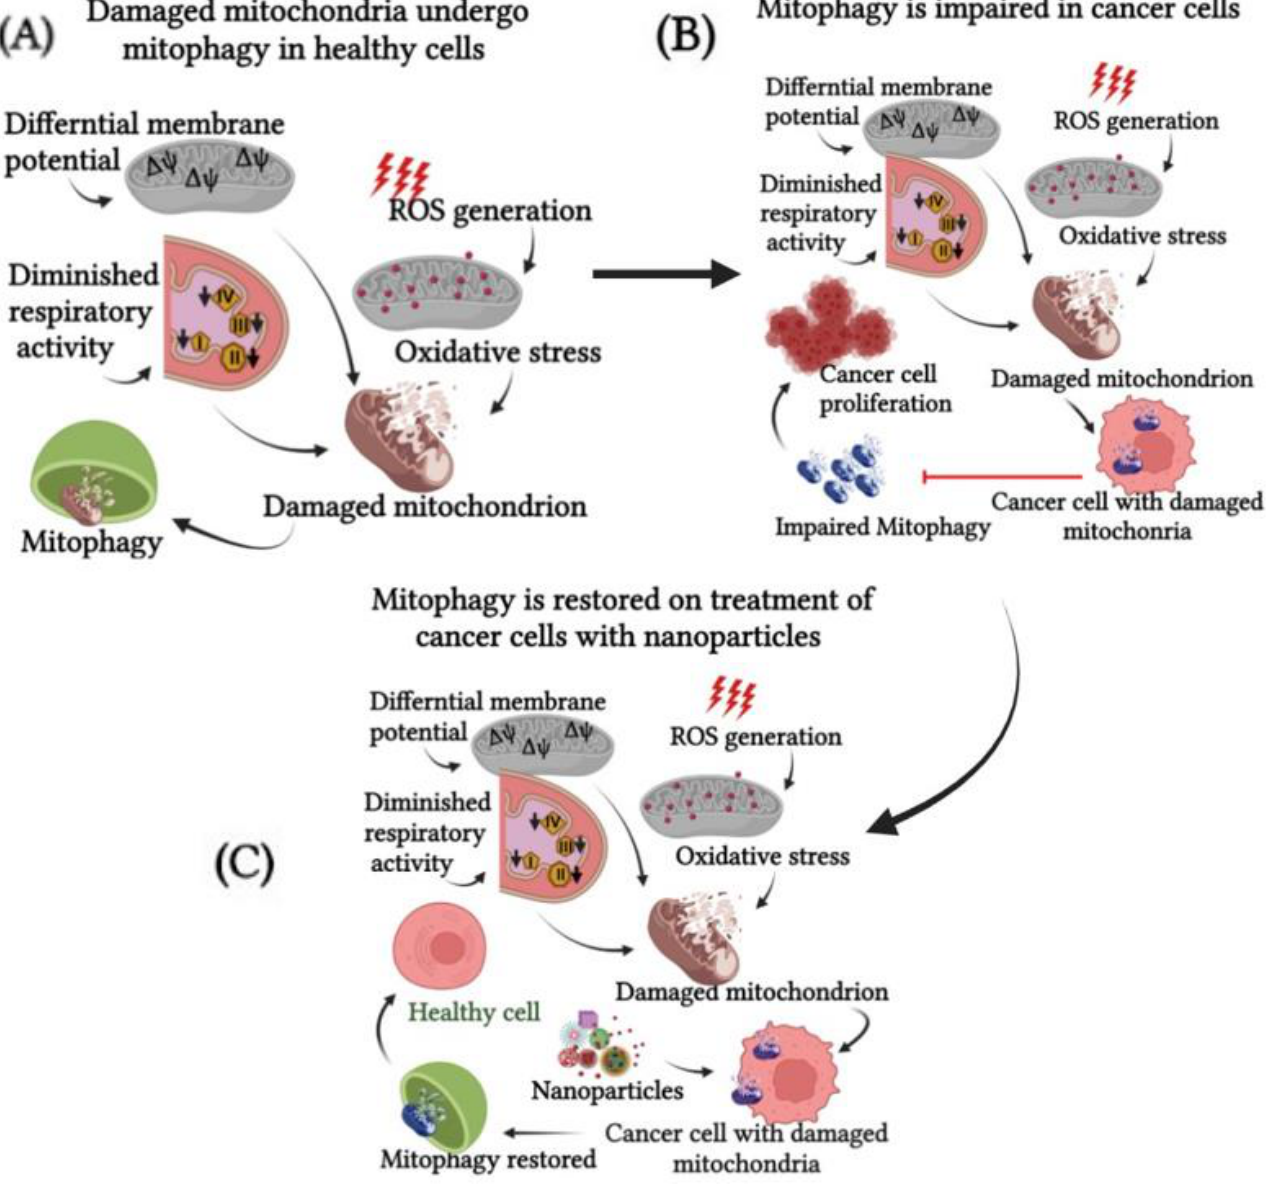
Figure 2. Effect of nanoparticles on mitophagy in cancer cells. Healthy cells undergo mitophagy ( A ) whereas cancer cells accumulate damaged mitochondria and mitophagy is impaired ( B ). Nanopar- ticles can restore normal homeostasis by restoring mitophagy and thus protecting the cells ( C ).